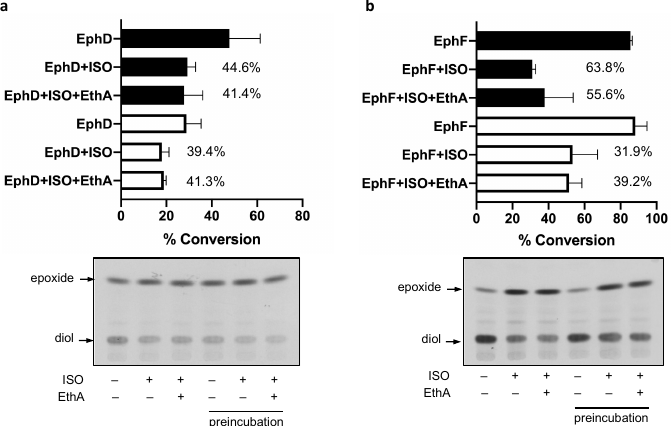
Figure 3. In vitro EH activity of EphD ( a ) and EphF ( b ) in the case of preincubation with 10 µg/mL of isoxyl (thiocarlide; 4,4′-diisoamyloxydiphenylthiourea) (ISO). Bar graph representing average percentages of substrate conversion from two experiments (error bars showing standard deviation). Filled bars represent reactions where ISO (or DMSO in control reactions) was added directly with other reaction components, empty bars represent reactions where the enzyme was incubated with ISO for 15 min prior to adding the substrate. Numbers next to bars represent average percentage of inhibition per reaction. The lower part of the figure shows one representative chromatogram from the TLC analysis of these reaction products. The presence (+) or absence (–) of ISO and EthA is indicated for each reaction.